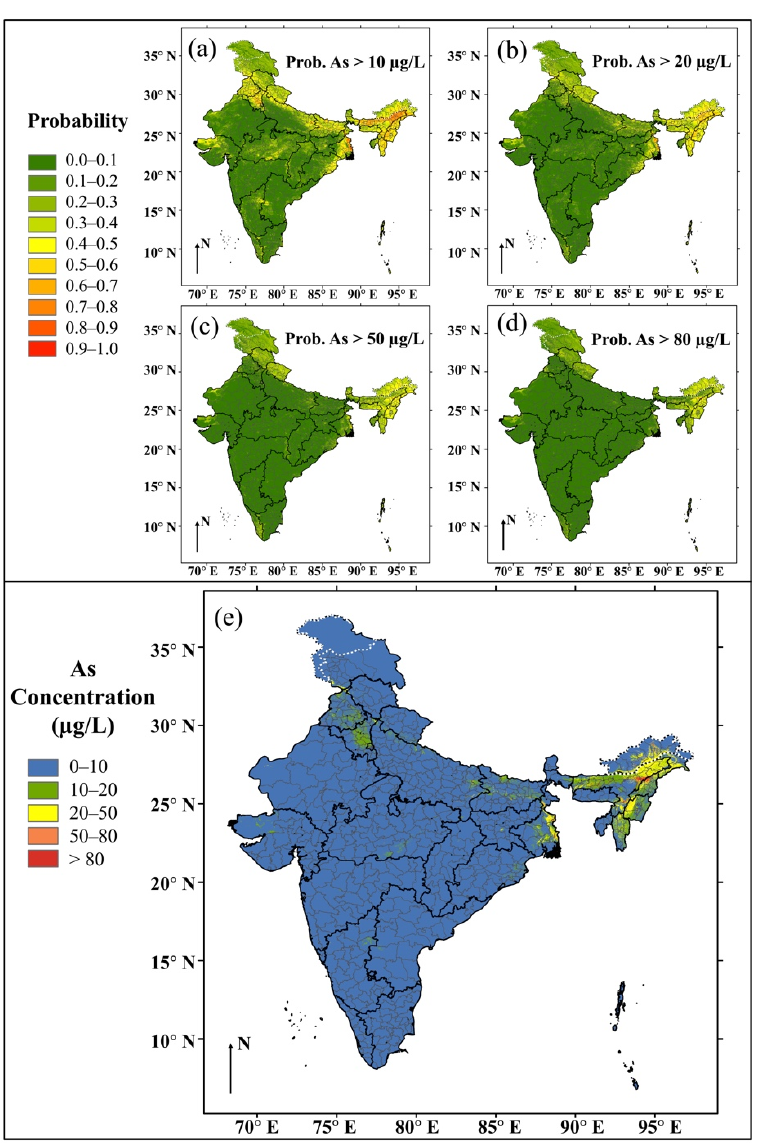
Figure 2. Modelled hazard maps of groundwater arsenic in India. Probability of groundwater arsenic exceeding ( a ) 10 μg/L, ( b ) 20 μg/L, ( c ) 50 μg/L, and ( d ) 80 μg/L. ( e ) Pseudo-contour map of groundwater arsenic concentrations defined here using a probability cutoff value of 0.5.